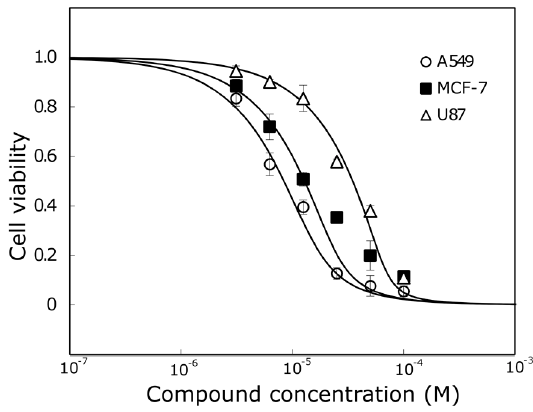
Figure 4. Comparison of compound 7 activity against A549, MCF-7 and U87 cell lines.